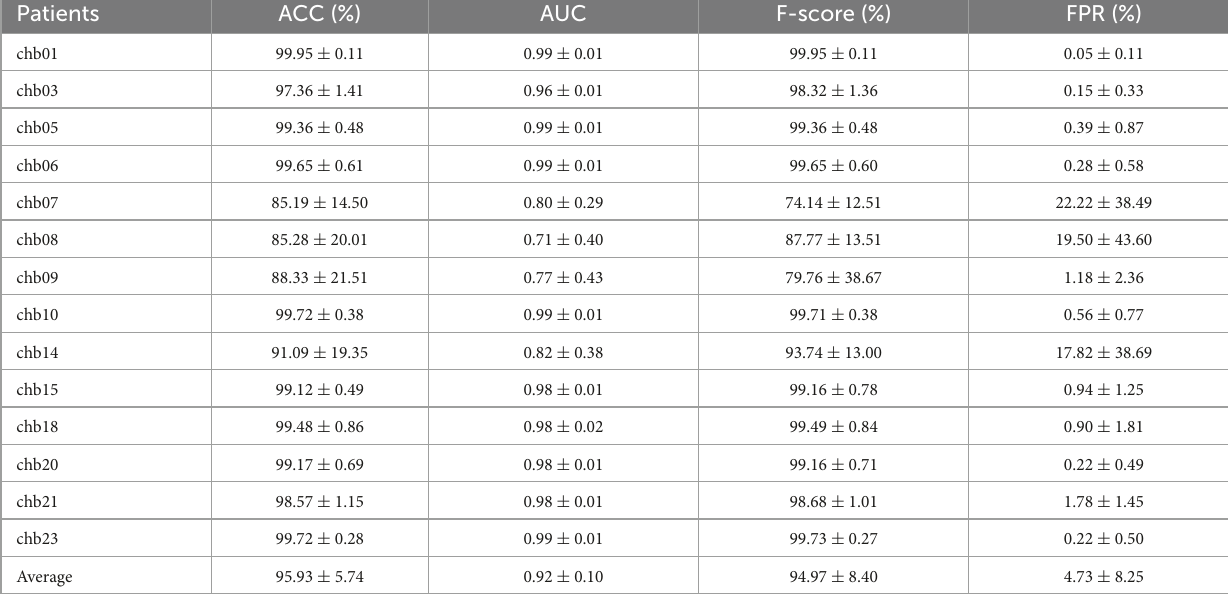
TABLE 6 Performance evaluation of our proposed method on the CHB-MIT dataset.